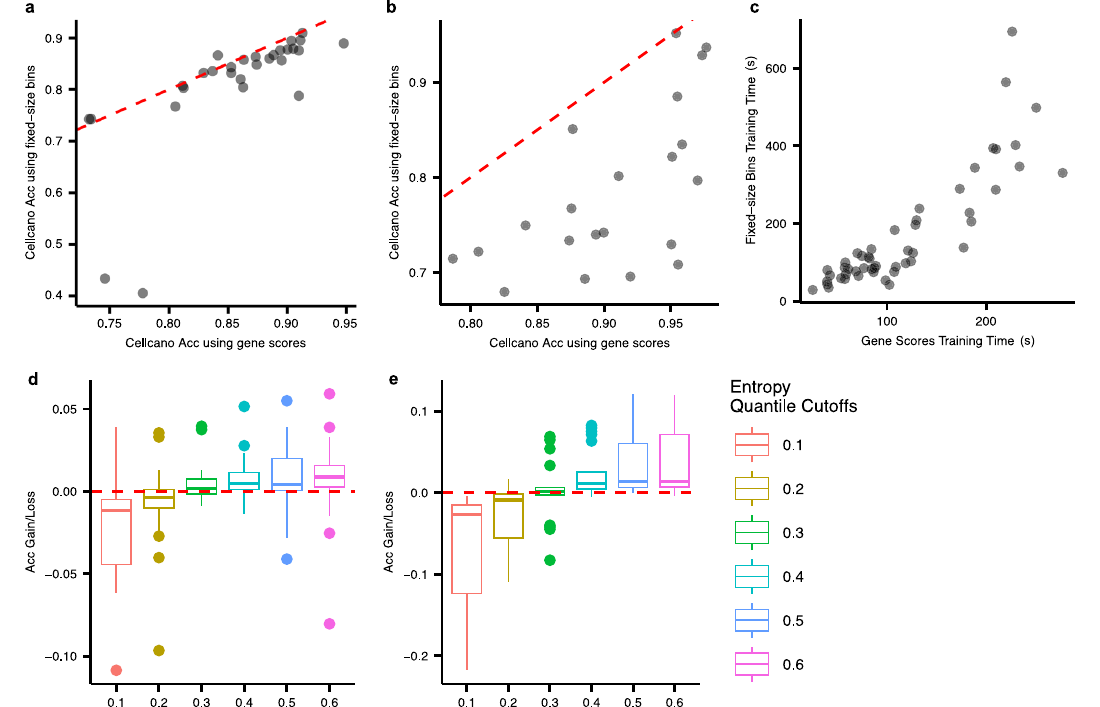
Fig. 2 | Cellcano ’ s parameter selection. a – c Focus on exploring performances between using different input for Cellcano. a , b Accuracies comparison on Cell- cano using genome-wide fi xed-size bins and gene scores as input from ( a ) n =29 human PBMCs celltyping tasks and ( b ) n =21 mouse brain celltyping tasks. The red dotted lines are identity lines. c Model training time comparison using the two different inputs on all n =50 celltyping tasks. d , e demonstrate the selection of the appropriate number of anchors. d , e Accuracy gains/losses using different entropy cutoffs on ( d ) n =29 human PBMCs celltyping tasks and ( e ) n =21 mouse